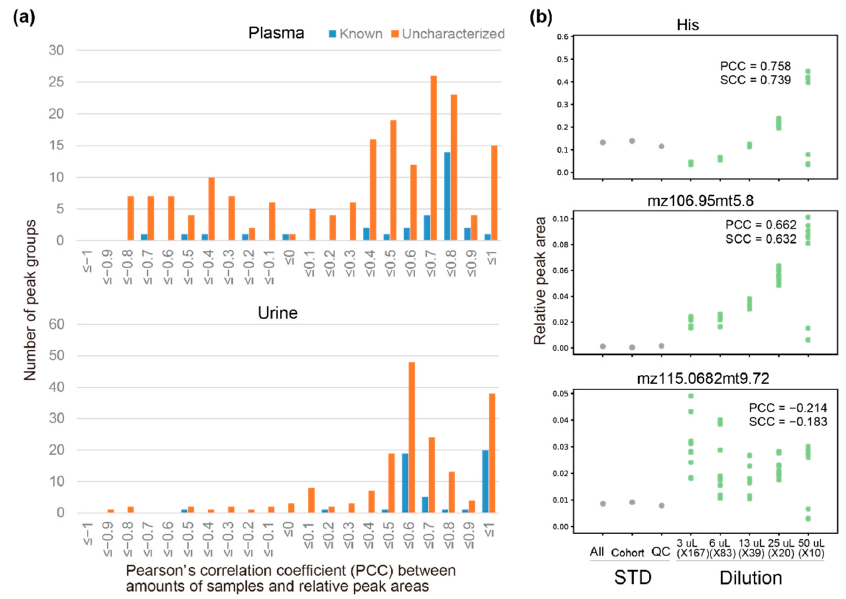
Figure 3. Relationships between the amounts of samples and relative peak areas. ( a ) Distribution of Pearson’s correlation coefficients (PCCs) between the amounts of samples and relative peak areas. Only peaks with signal-to-noise (S/N) ratios >5 in the independently pooled samples were included in this analysis. ( b ) Relationships between the amounts of samples (determined by dilution rates) and the peak areas. PCC and SCC (Spearman’s correlation coefficient) values are shown. Three types (“All”, “Cohort”, “QC”) of standard solutions (STDs) measured together are shown for comparison. “All” contains 278 standard compounds (cations) whereas “Cohort” and “QC”, contain 62 standard compounds (cations). They are also measured in the TMCS routine.